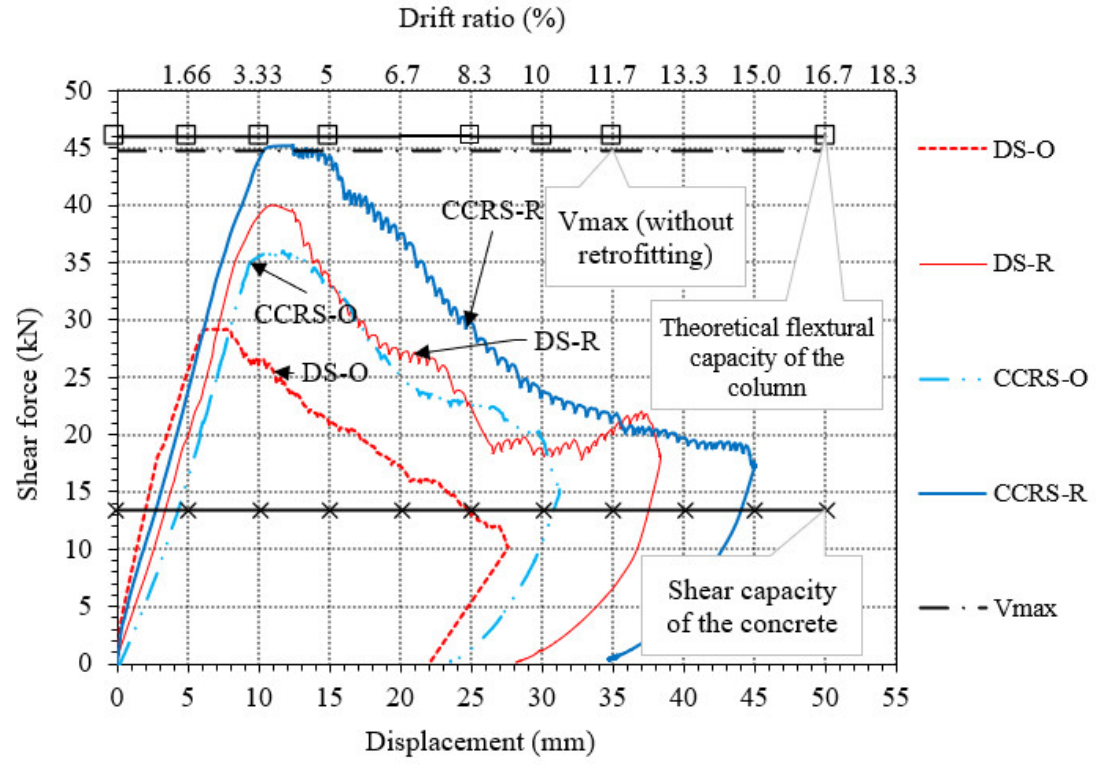
Figure 17. Lateral load deflection relationship.